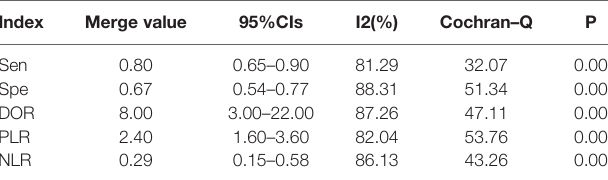
TABLE 2 | The combined predictive value of preoperative serum HE4 in 8 included studies.